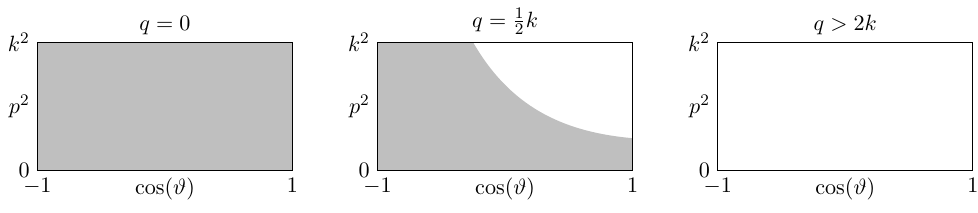
Figure 10 . The value of (cid:2)( k 2 (cid:0) ( ~p + ~q ) 2 ) for three di(cid:11)erent values of q . In the gray regions the step function evaluates to 1 while it vanishes in the white